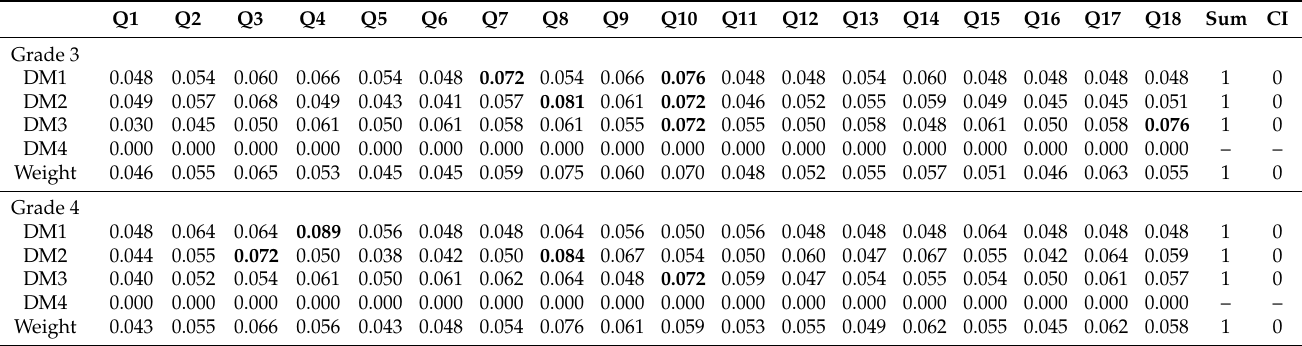
Table 2. The weight and the ranking of VGAS criteria for grades 3 and 4.